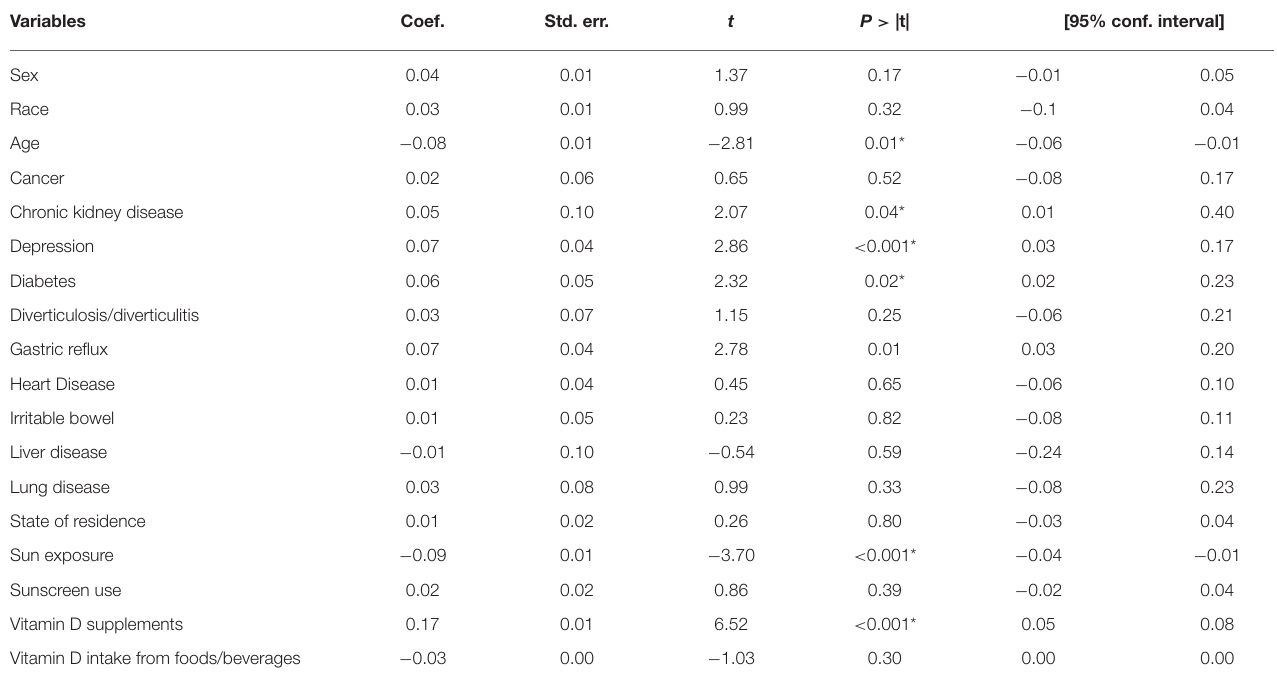
TABLE 3 | Multivariable associations on vitamin D status. Variables